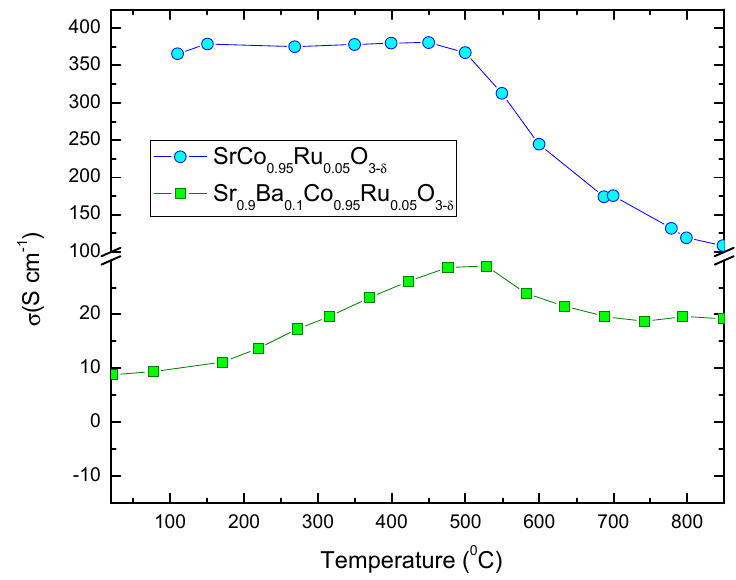
Figure 6. Thermal evolution of the dc electrical conductivity of Sr 0.9 Ba 0.1 Co 0.95 Ru 0.05 O 3 − δ compared with the parent compound Sr 0.9 Co 0.95 Ru 0.05 O 3 − δ .